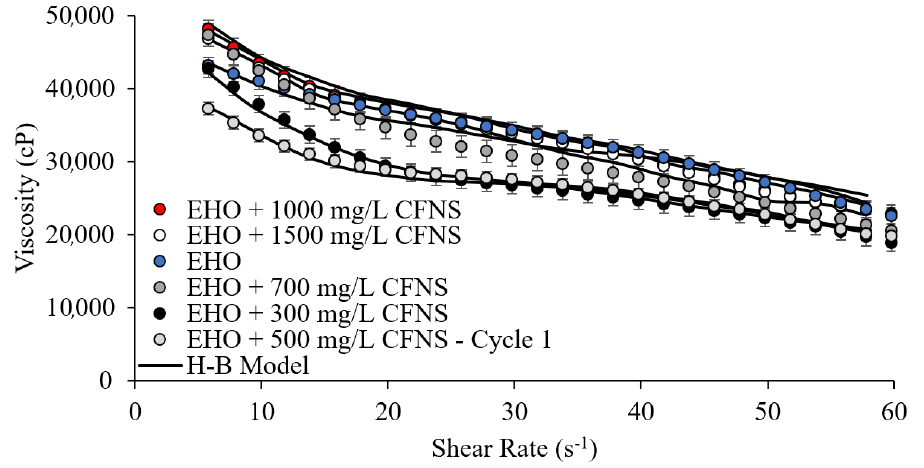
Figure 3. Flow curve for the extra-heavy oils (EHO) on the presence of CFNS at different dosages, and the Herschel– Bulkley model correlation, at 25 °C.